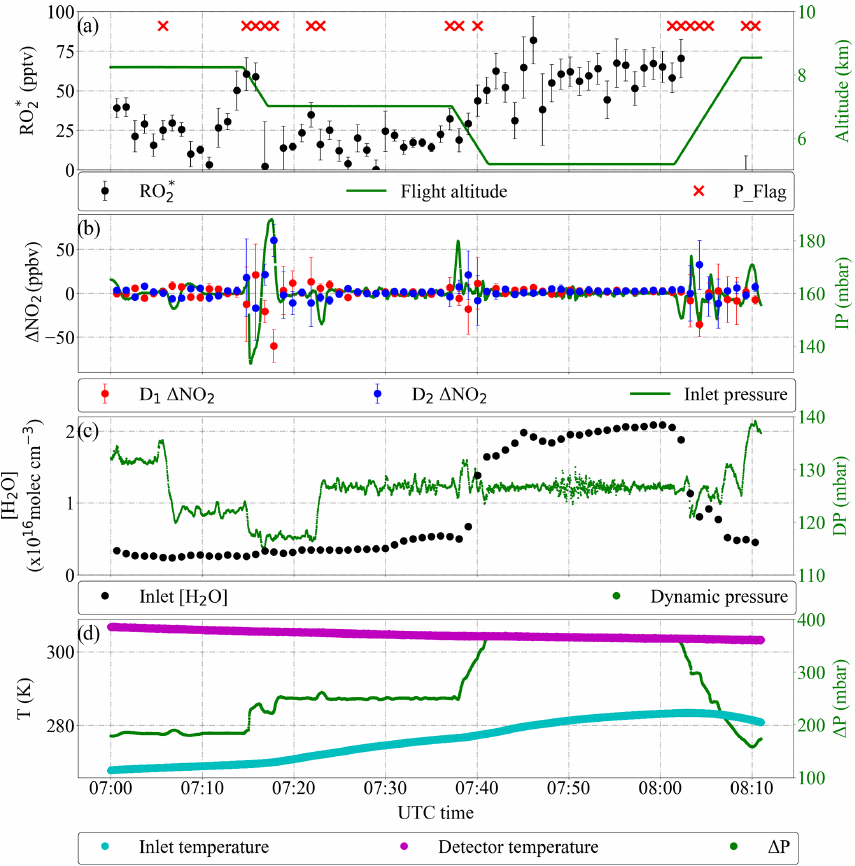
Figure 18. Detail of PeRCEAS measurements during the OMO flight on 25 August 2015. The DUALER I inlet was operated with 15ppmv NO and at 160mbar. (a) Retrieved RO ∗ and flight altitude. Pressure variations with 1min standard deviation >2mbar are flagged 2 (red crosses); (b) (cid:49) NO 2 calculated from detector 1 (red dots), detector 2 (blue dots) and DUALER pressure. (c) Water number concentration in DUALER and dynamical pressure experienced by the aircraft. (d) DUALER inlet, detector temperature and pressure difference between inlet and outside pressure ( (cid:49)P